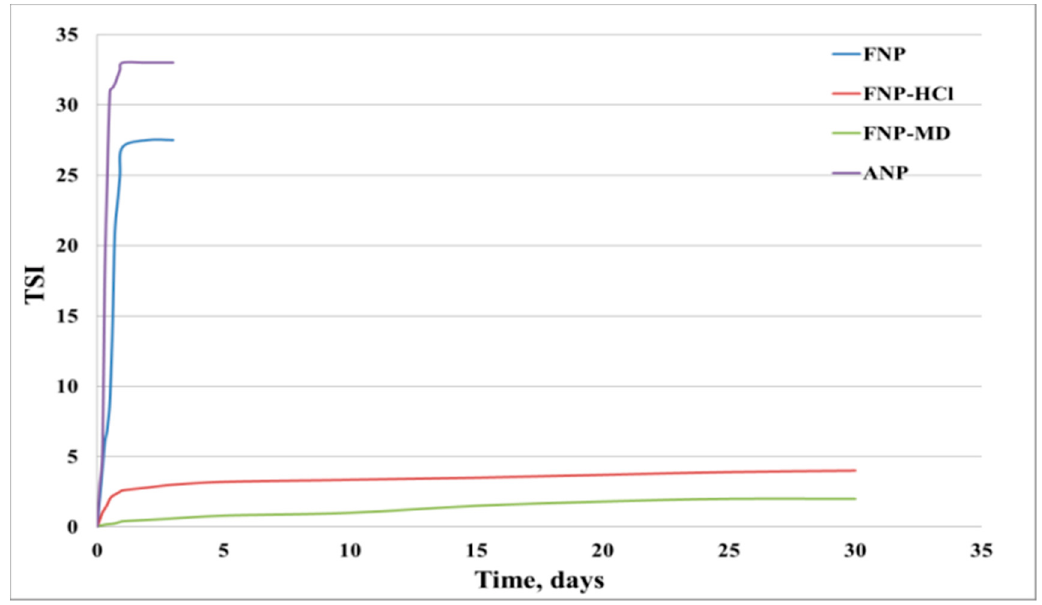
Figure 5. Turbidity scan index (TSI) results for nanoparticles suspensions.